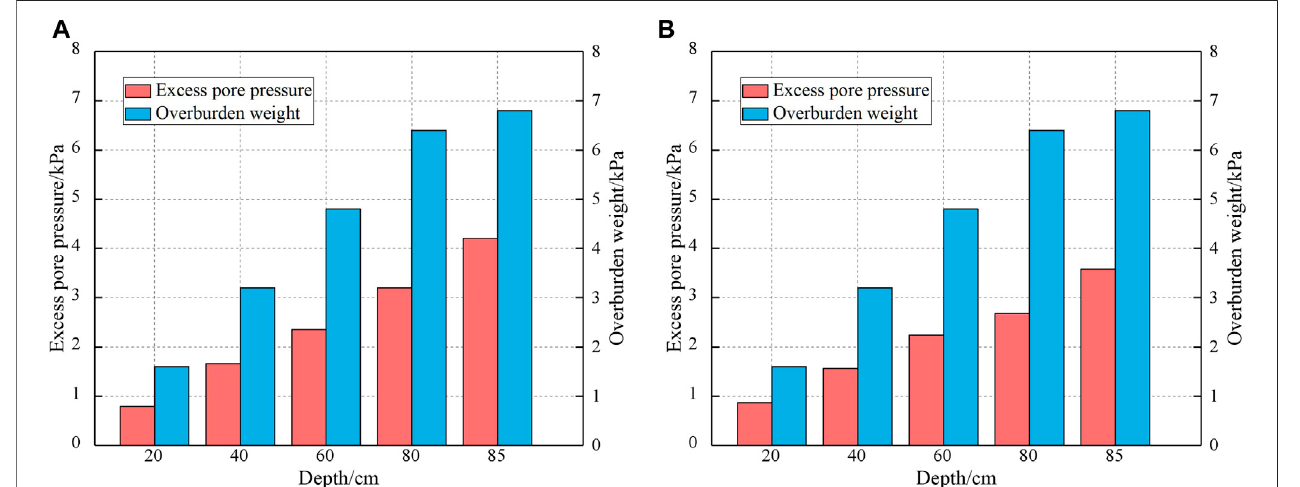
FIGURE 9 | The excess pore pressure at the pile surface and overburden weight with depth: (A) TP1, (B) TP2.